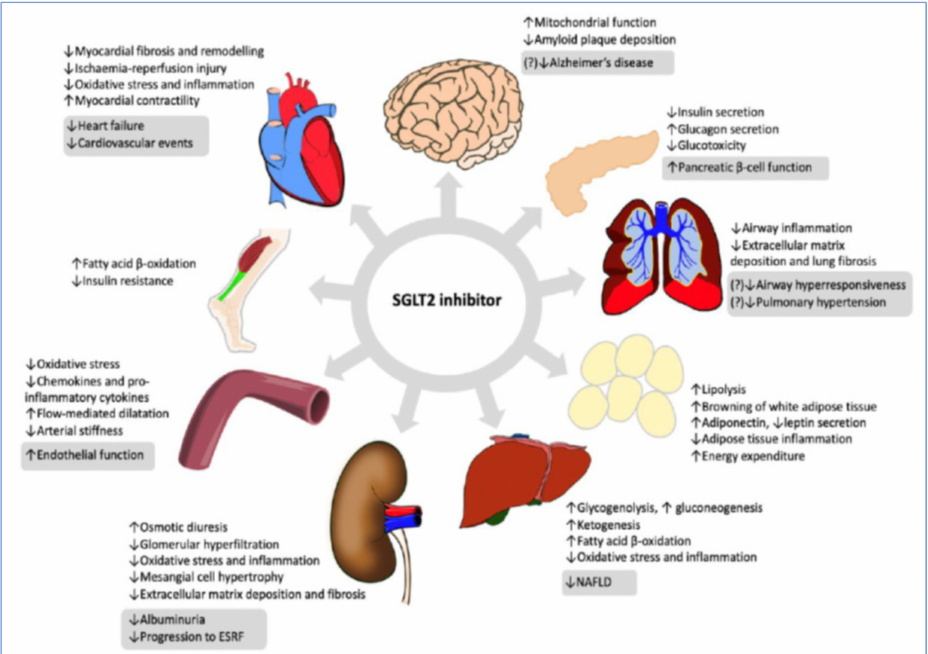
Figure 7. Sodium glucose cotransporter 2 (SGLT2) inhibition has pleiotropic effects on multiple organ systems. Hoong, C.W.S. et al. Endocrinology 2021 (Ref.